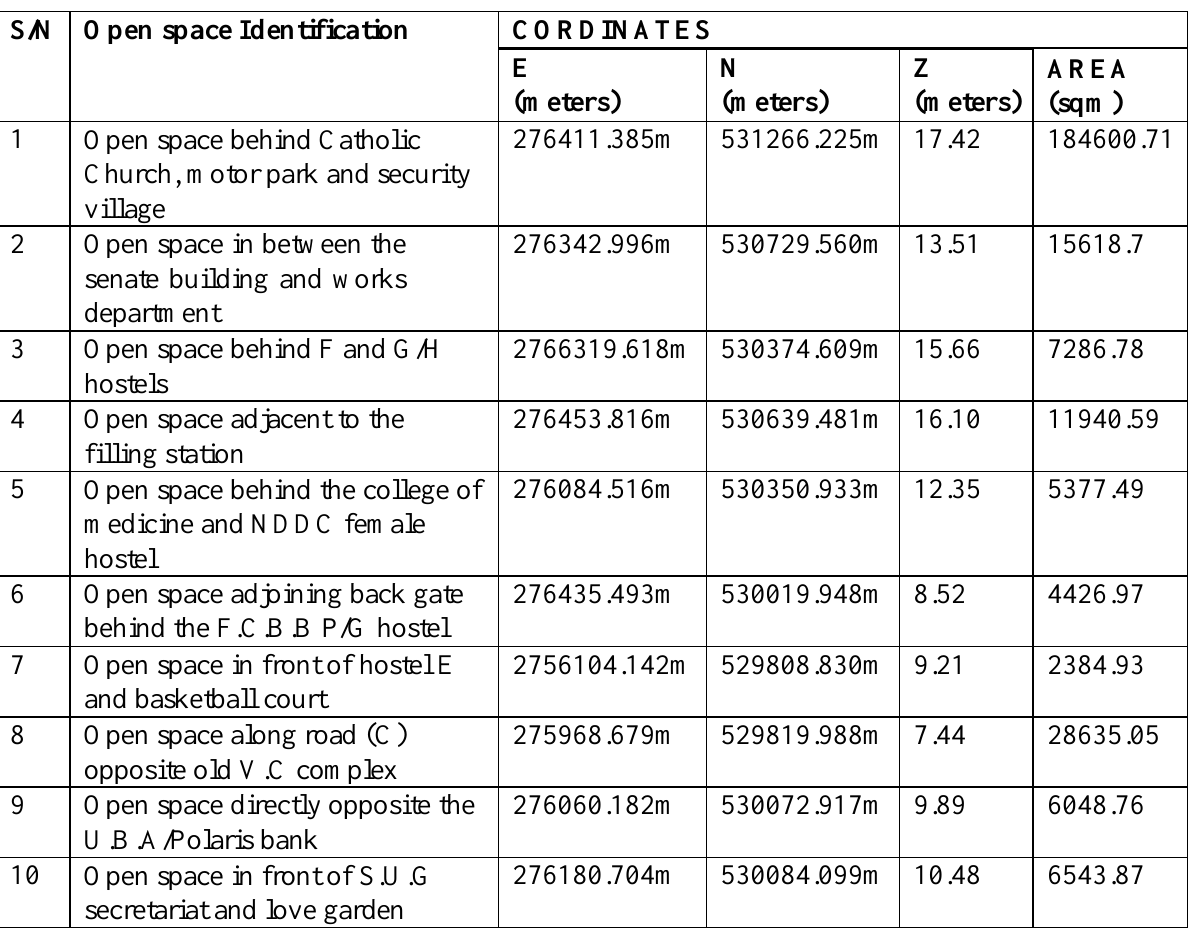
Table 4: Location and sizes of Open Spaces in Zone (D)